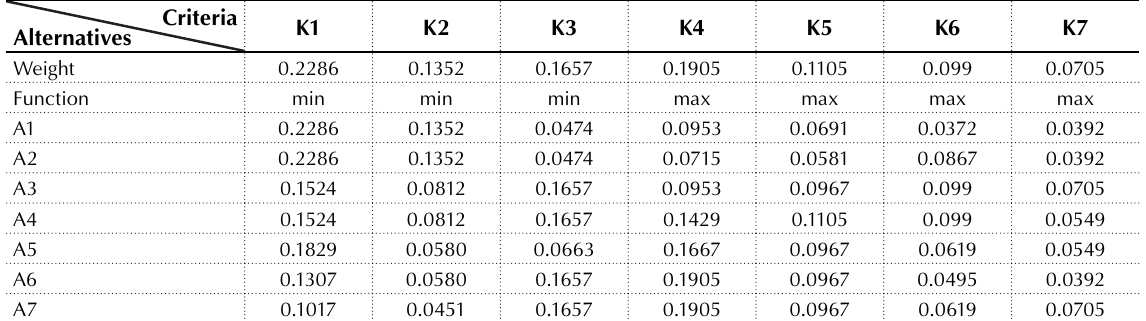
Source: Compiled by